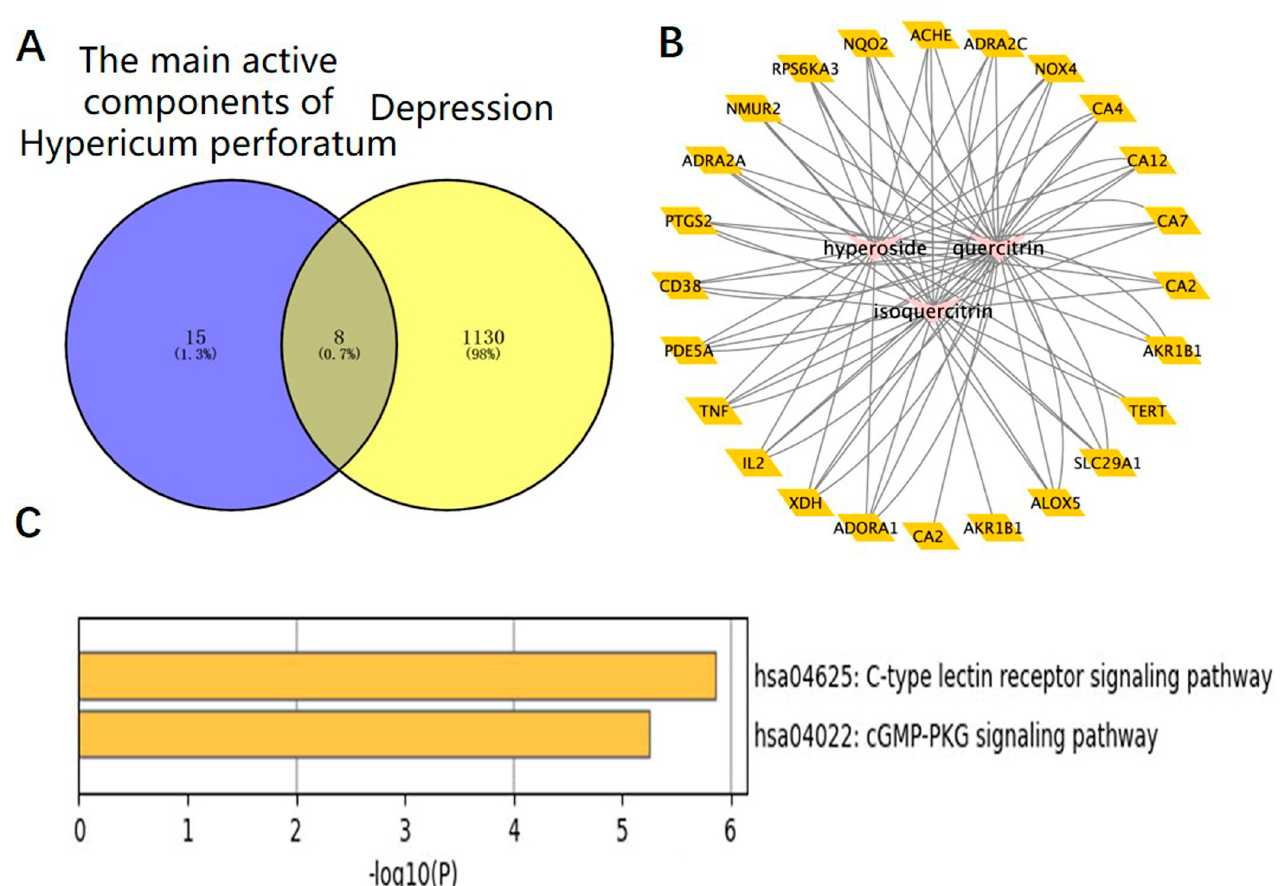
Figure 5. HP’s main active components (Hyp, isoquercetin, and quercetin) and depression: a network pharmacology map. ( A ) Venn diagram of the main active components of HP and depression-related targets. ( B ) The main active components of HP and their corresponding antidepressant targets were imported into Cytoscape software to construct an active component-target network diagram. ( C ) KEGG pathway analysis of intersection targets for Hyp and depression.